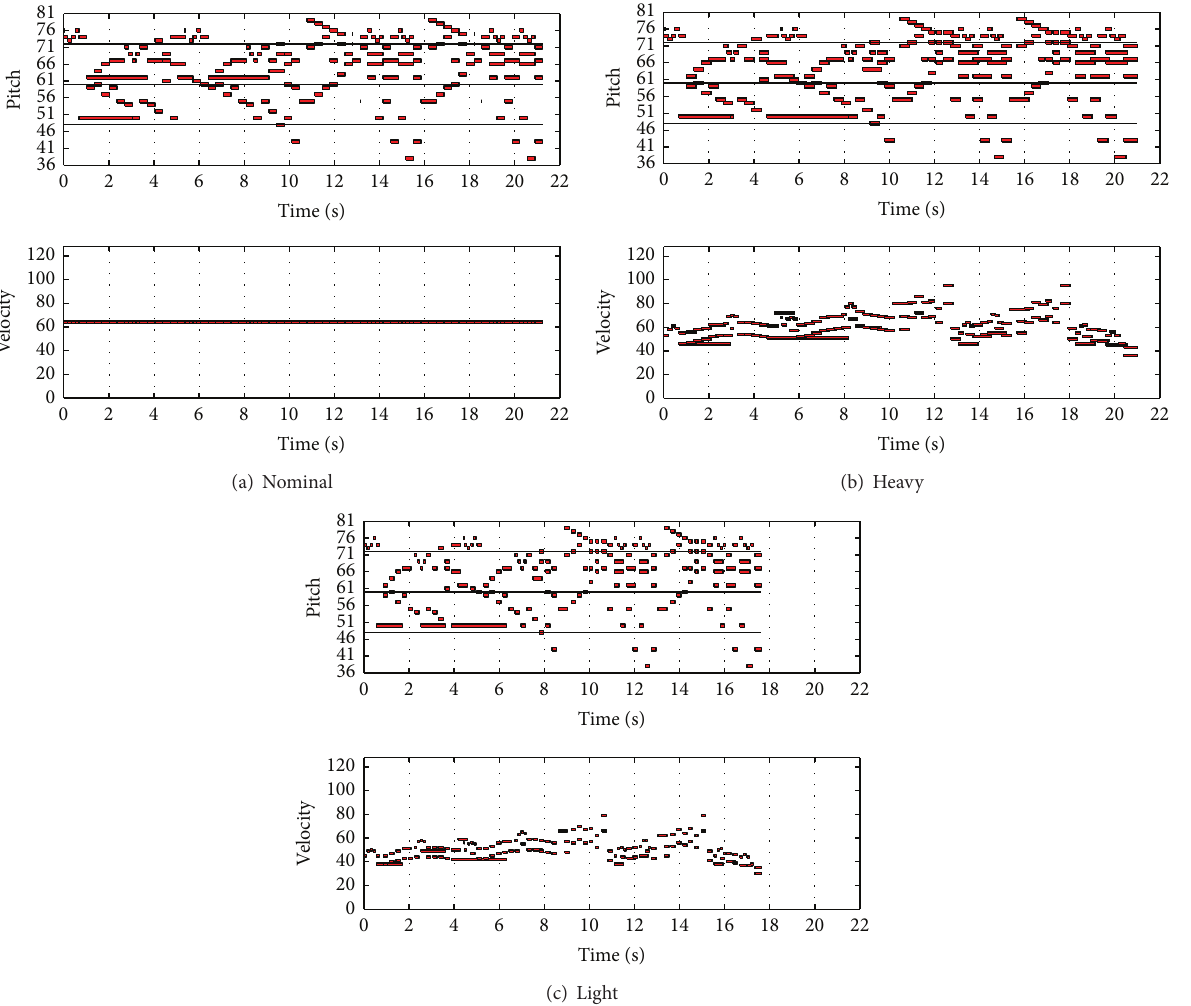
Figure 12: Piano roll representation of the performances characterized by heavy (b) and light (c) expressive intention. The nominal performance (a) has been added as a